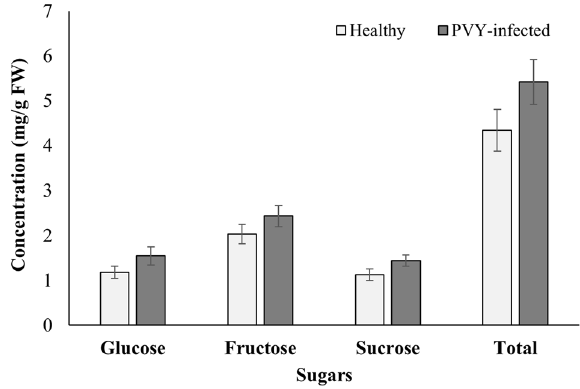
Figure 4. Sugar concentration in healthy and PVY-infected tomato plants. There were no significant effects of PVY infections on the sugar concentrations in tomato seedlings. Error bars represent standard error (± SE).